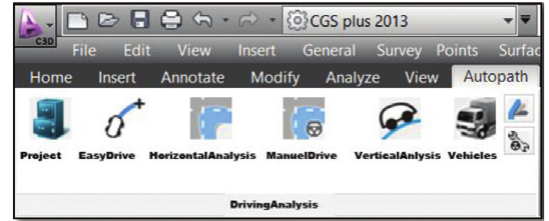
Fig. 1. CGS Plateia driving analysis module interface